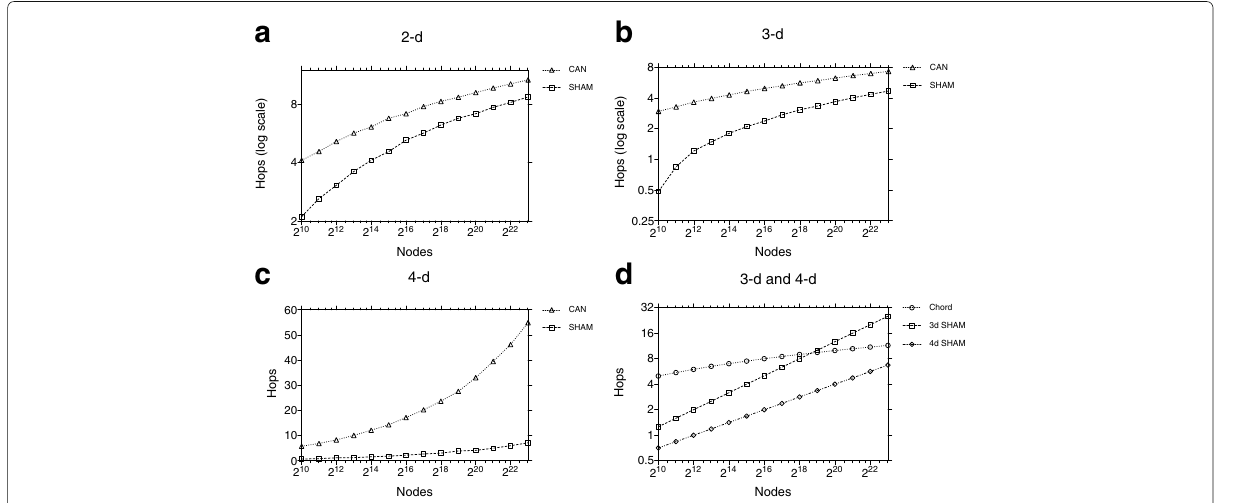
Fig. 9 a – d Average path length in SHAM, CAN, and Chord